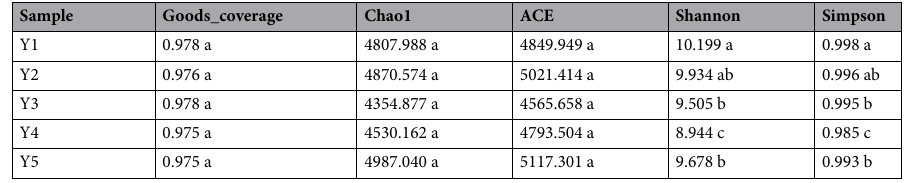
Table 2. Alpha diversity indices. Goods_coverage: indicator reflects the depth of sequencing, the closer the value is to 1, the more reasonable the sequencing depth, indicating that the sequencing depth has covered all species in the sample; Chao1: provides an estimation of the actual number of OTUs in the sample as an indicator of species richness, the higher value means higher species richness; ACE: an indicator of species richness, the higher value means higher species richness, with a different algorithm to Chao1; Shannon: an index quantifies the entropy of the distribution, which depends on the evenness and richness of the proportional abundances of OTUs in the population, the higher value means higher species diversity; Simpson: an indicator of species diversity, the higher value means higher species diversity with a different algorithm to Shannon; different lower-case letters indicate significant differences ( p < 0.05) among the 5 treatments.